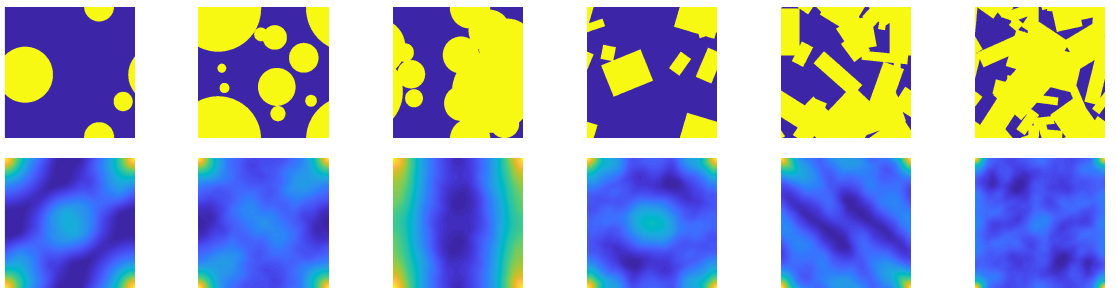
Figure 1. Depicting some exemplary microstructures with their respective 2-point spatial correlation functions c 2 ( r ; b , b )